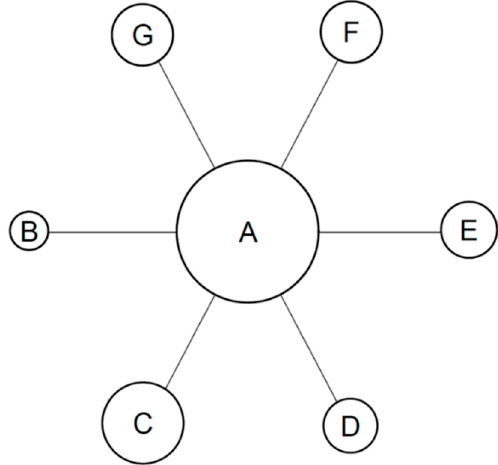
Figure 1. Star shaped network diagram generated in this safety MA. Only direct comparisons of immunotherapies versus overall chemotherapy as common comparator are shown. A = common comparator, platinum-based chemotherapy control group; B = KEYNOTE-024 (pembrolizumab); C = KEYNOTE-042 (pembrolizumab); D = CheckMate 026 (nivolumab); E= IMpower110 (atezoli- zumab); F = MYSTIC (durvalumab) and G = EMPOWER-Lung 1 (cemiplimab). Circle size is propor- tional to the number of patients receiving the specific treatment in each clinical trial included in the NMA.